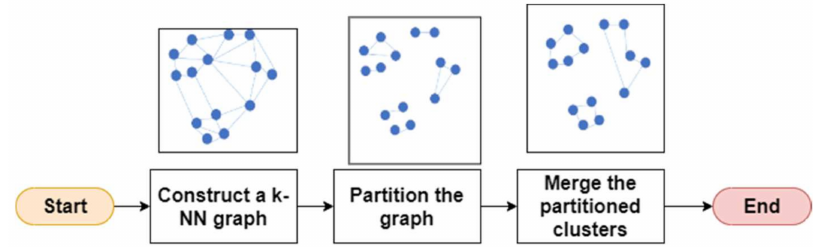
Figure 5. Basic steps of CHAMELEON